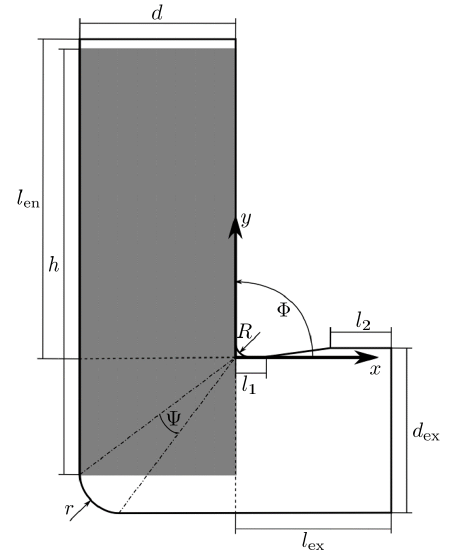
Figure 2. Sketch of the simulation model with the relevant geometrical parameters.